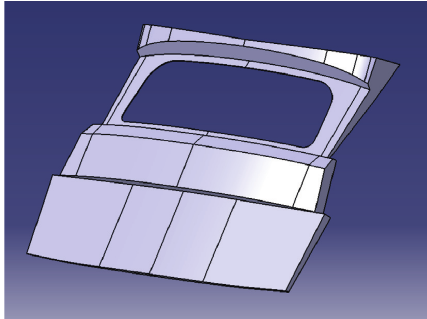
Figure 1: 3D parts